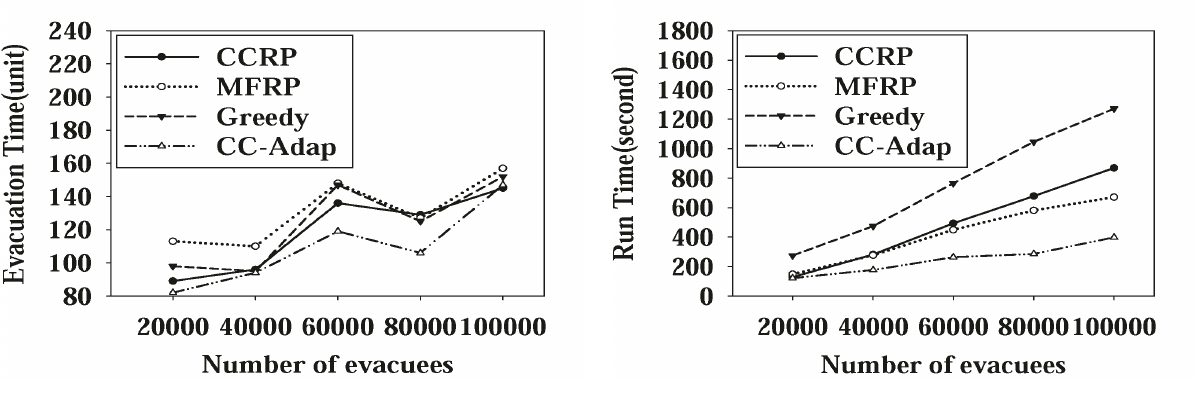
Figure 9: Evacuation quality of large-scale transportation network